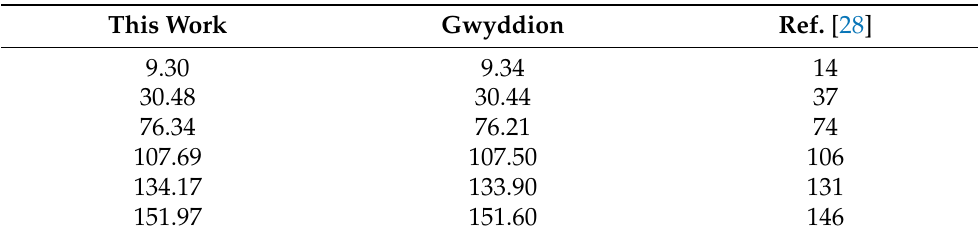
Table 2. Comparing the calculated rms roughness extracted from the original AFM images based on different numerical